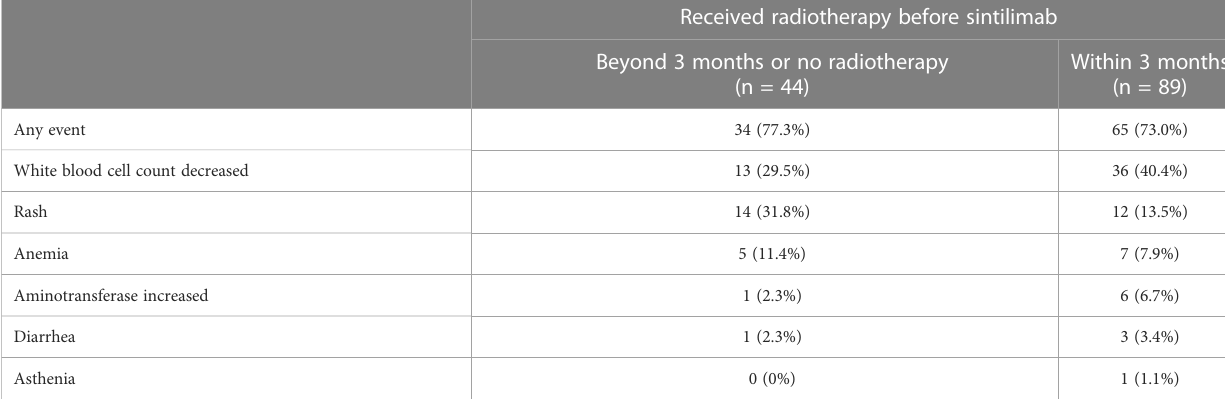
TABLE 4 Adverse events of subgroup patients (n =